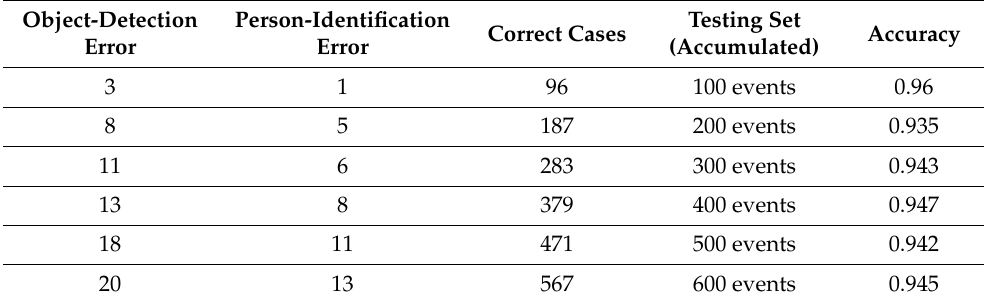
Table 5. Test of the entire system.